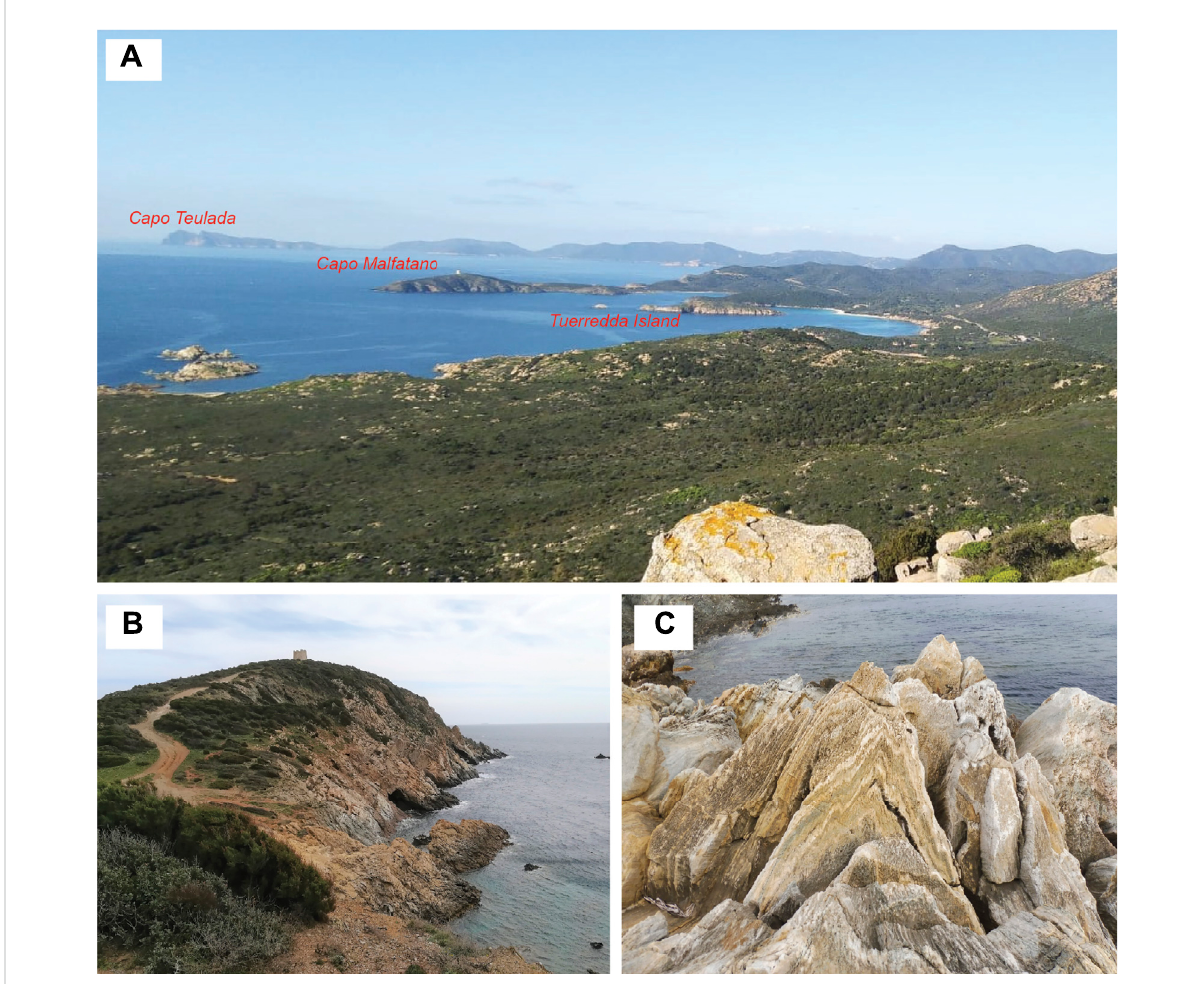
FIGURE 8 (A) View (toward SW) from Mt.Sa Guardia Manna (stop4) ofthe Capo Malfatano promontoryand the Tuerredda island in theforeground; inthe background can be recognized the Capo Teulada promontory; (B) view of the Capo Malfatano tower looking toward south, with the phyllites of